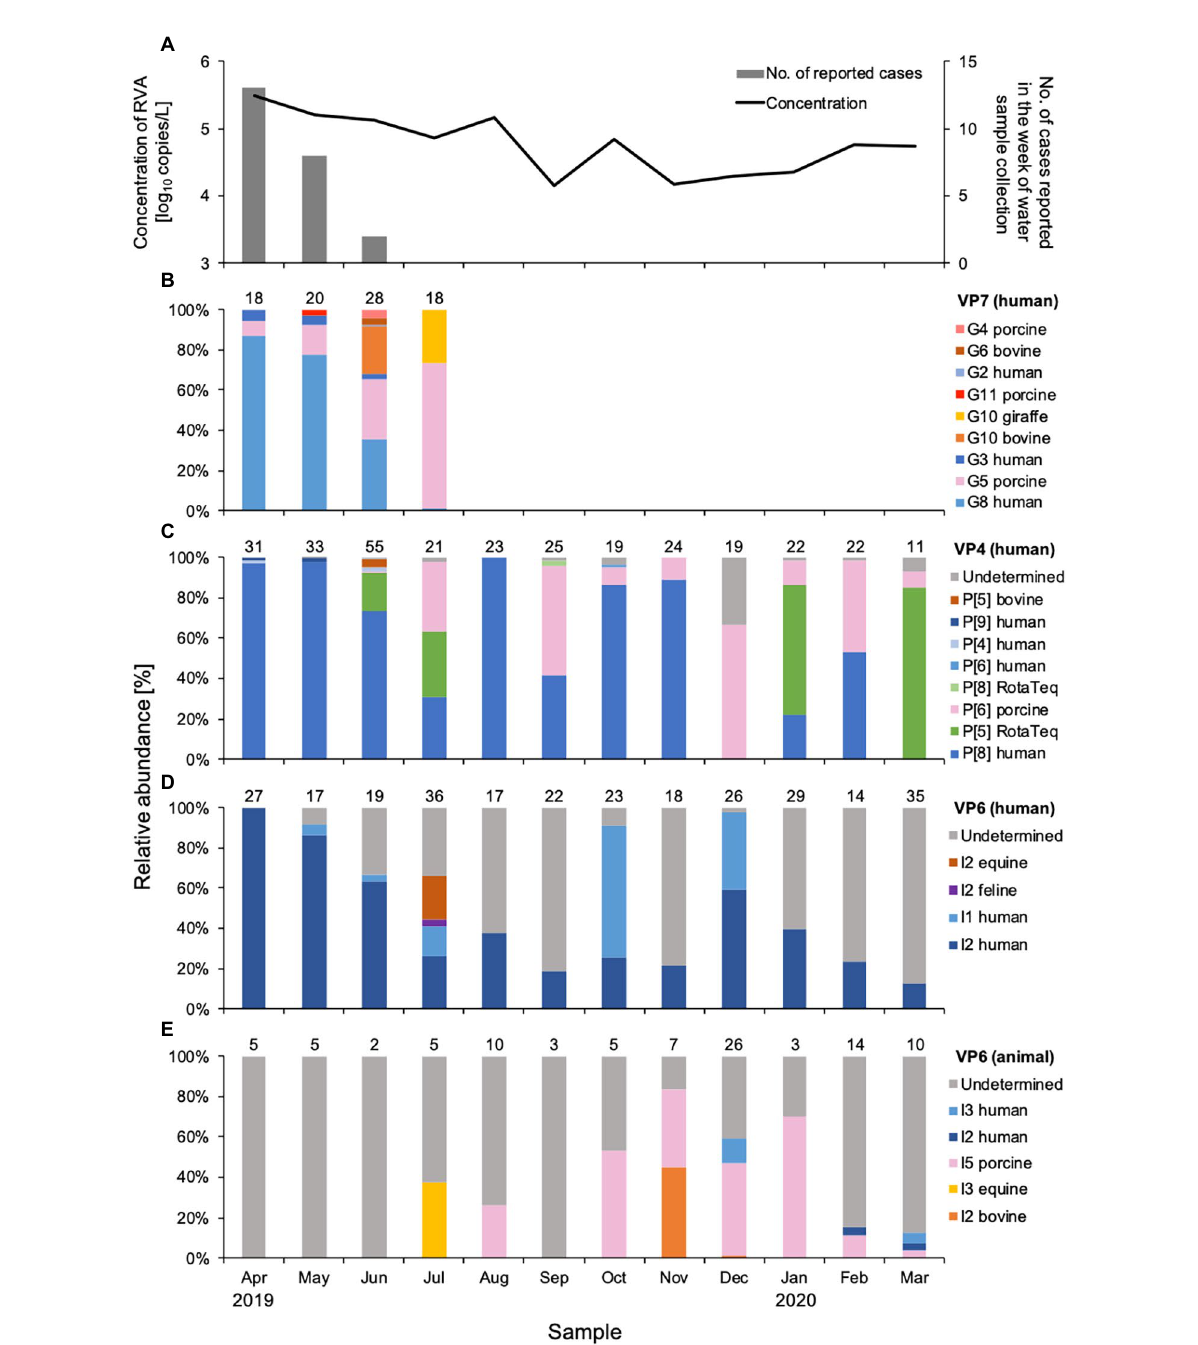
FIGURE 1 Concentration and genetic diversity of Rotavirus A (RVA) in water samples from DWTP E. The RVA NSP3 gene was quantitatively detected by real- time RT-PCR and plotted together with cases of rotavirus gastroenteritis reported for the week of sample collection in the prefecture upstream (A) . Relative abundance (%) was calculated for RVA G genotypes determined by the VP7 gene (B) , P genotypes determined by the VP4 gene (C) , and I genotypes determined by the VP 6 gene amplified in human (D) and animal (E) nested PCR assays. The value above each column of relative abundance represents the number of OTUs with > 500